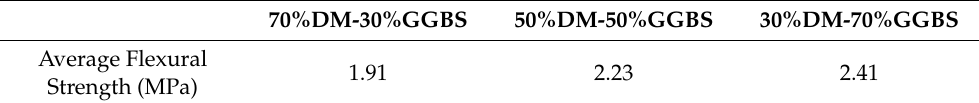
Figure 7. Flexural Strength vs. Maturity per Mixture. Table 5. Average Flexural strength of Paving flags per Mixture.